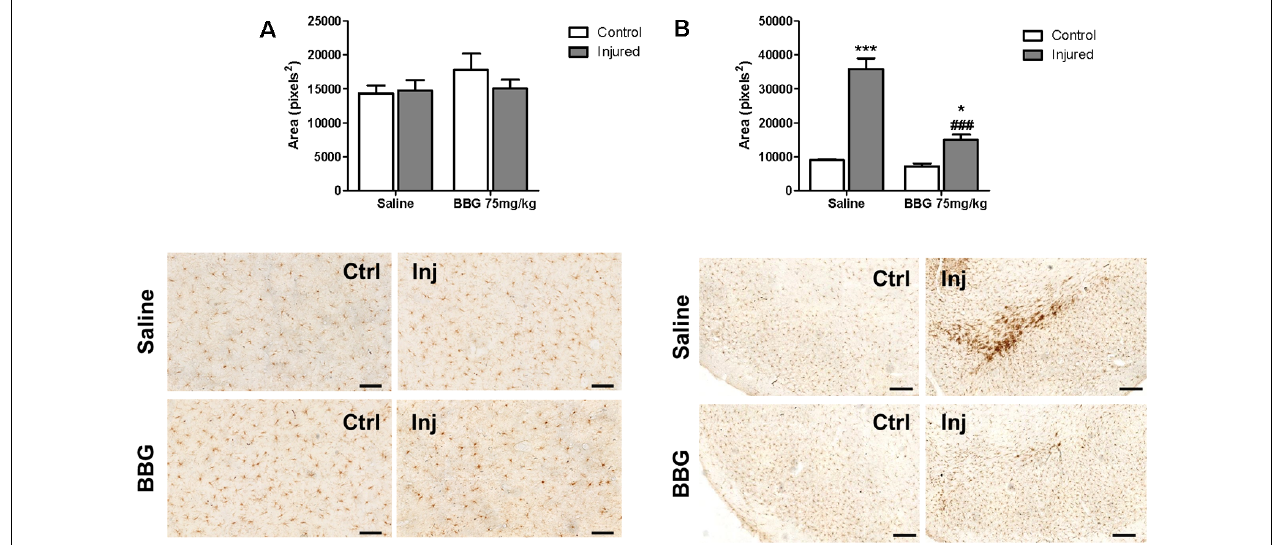
FIGURE 4 | Microglial activation determined as Iba-1 labeling in hemispheres of BBG-treated and untreated animals. Animals were treated with 75 mg/kg daily for 7 days, 1 week after 6-OHDA- induced injury (7 µ g/kg). (A) Striatum , scale bar: 100 µ m; F ( 1,20 ) = 0.900, p = 0.354; and (B) substantia nigra , scale: 200 µ m; F ( 1,20 ) = 28.274, p < 0.001. Areas labeled by Iba-1 immunostaining in control (Ctrl) and injured hemispheres (Inj) were subjected to densitometric analysis, and results are expressed as mean values ± standard errors of the mean. ∗ p < 0.05, ∗∗∗ p < 0.001 in relation to respective control hemisphere; ### p < 0.001 in relation to injured hemisphere from saline group. n = 6 for each group. Two-way ANOVA followed by the Bonferroni post hoc